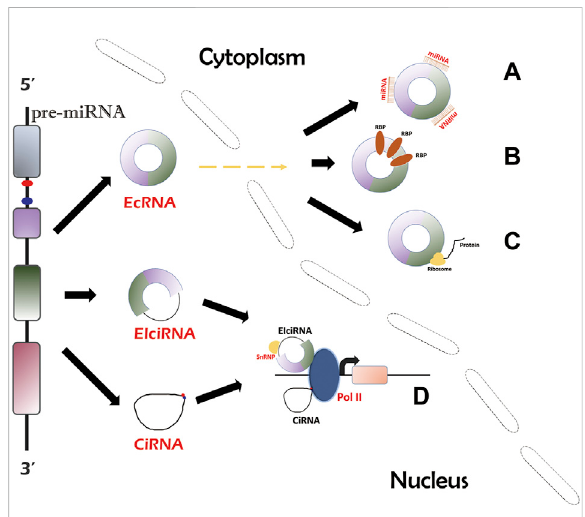
FIGURE 1 Biogenesis and circRNA action mechanisms. There are three types of circRNAs. EcRNAs can be transported into cytosol and account for the majority of circRNAs, while EIciRNAs and ciRNAs are con fi ned to the nucleus. EcRNAs can act as miRNA/RBP sponges (A,B) and protein translation templates (C) . EIciRNAs and ciRNAs can function by regulating parental gene transcription (D)